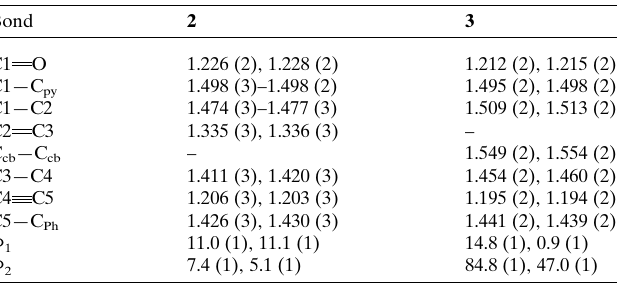
Table 1 Selected geometry parameters (A˚ , (cid:3) ) for 2 and 3 . The carbon atoms of the pentenynone fragment are numbered from 1 to 5. (cid:2) 1 is the dihedral angle between the pyridine ring and the ketone fragment and (cid:2) 2 is the dihedral angle between the pyridine and phenyl rings.